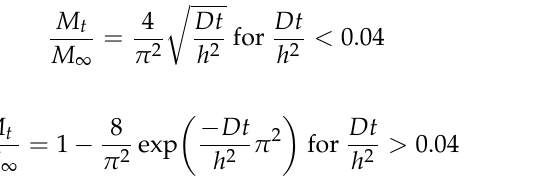
The diffusion coefficient D in the direction normal to the material surface can be computed by applying Formula (5) from the initial linear portion of the absorption curve using the long-term approximation according to Fick’s diffusion model: